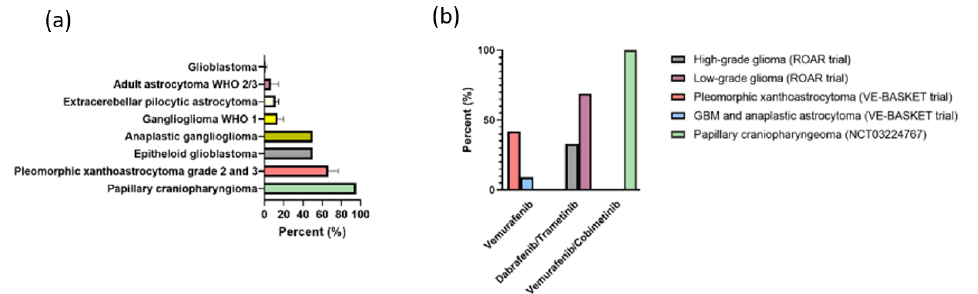
Figure 1. ( a ) Prevalence of v-RAF Murine Sarcoma Viral Oncogene Homolog B1 (BRAF) V600E mutation in papillary craniopharyngioma, pleomorphic xanthoastrocytoma, ganglioglioma, glioblas- toma, pilocytic astrocytoma and adult astrocytoma World Health Organization (WHO) 2/3; ( b ) Response rates of vemurafenib monotherapy (VE-BASKET study), combined therapy with dabrafenib/trametinib in low- and high-grade glioma (NCT02034110) and vemurafenib/cobimetinib in papillary craniopharyngioma